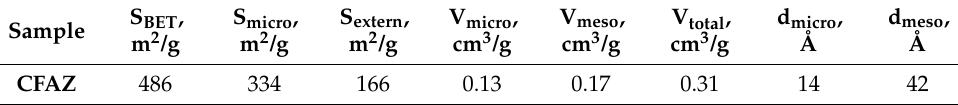
Table 1. Surface parameters of CFAZ studied as an adsorbent of CO 2 .